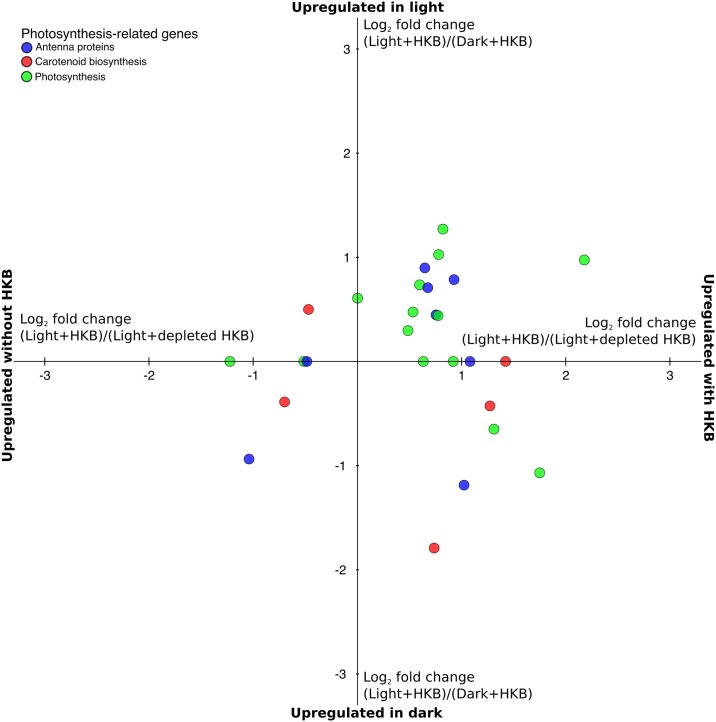
Fold change of differentially expressed genes related to photosynthesis of Ochromonas sp. strain CCMP1393.Average log2 fold change of differentially expressed genes related to photosynthesis of Ochromonas sp. strain CCMP1393 in the pairwise comparisons: Light+HKB vs. Dark+HKB (y-axis); and Light+HKB vs. Light+depleted HKB (x-axis). Values above the x-axis indicate genes upregulated in the Light+HKB treatment compared to the Dark+HKB treatment, while values to the right of the y-axis indicate genes upregulated in the Light+HKB treatment compared to the Light+depleted HKB treatment. Values on the x-axis indicate genes not differentially expressed between the Dark+HKB and Light+HKB treatments (i.e. expression of these were only affected by the availability of prey), while values on the y-axis indicate genes not differentially expressed between the Light+HKB and Light+depleted HKB treatments (i.e. expression of these were only affected by the availability of light). Colors indicate the KEGG ortholog group of the gene.